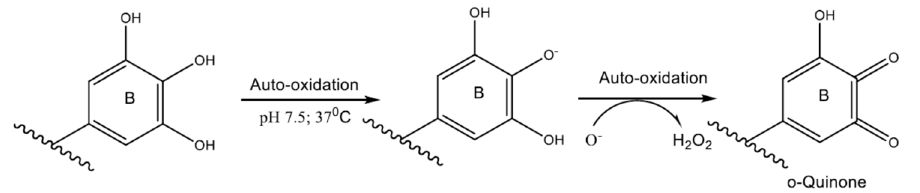
Figure 5. Superoxide-mediated chain reaction formation of o-quinone.